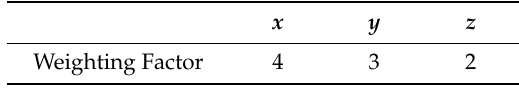
Table 3. Weighting Factor.